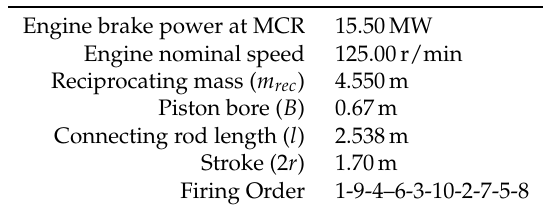
Table 3. Reference engine basic characteristics [27].